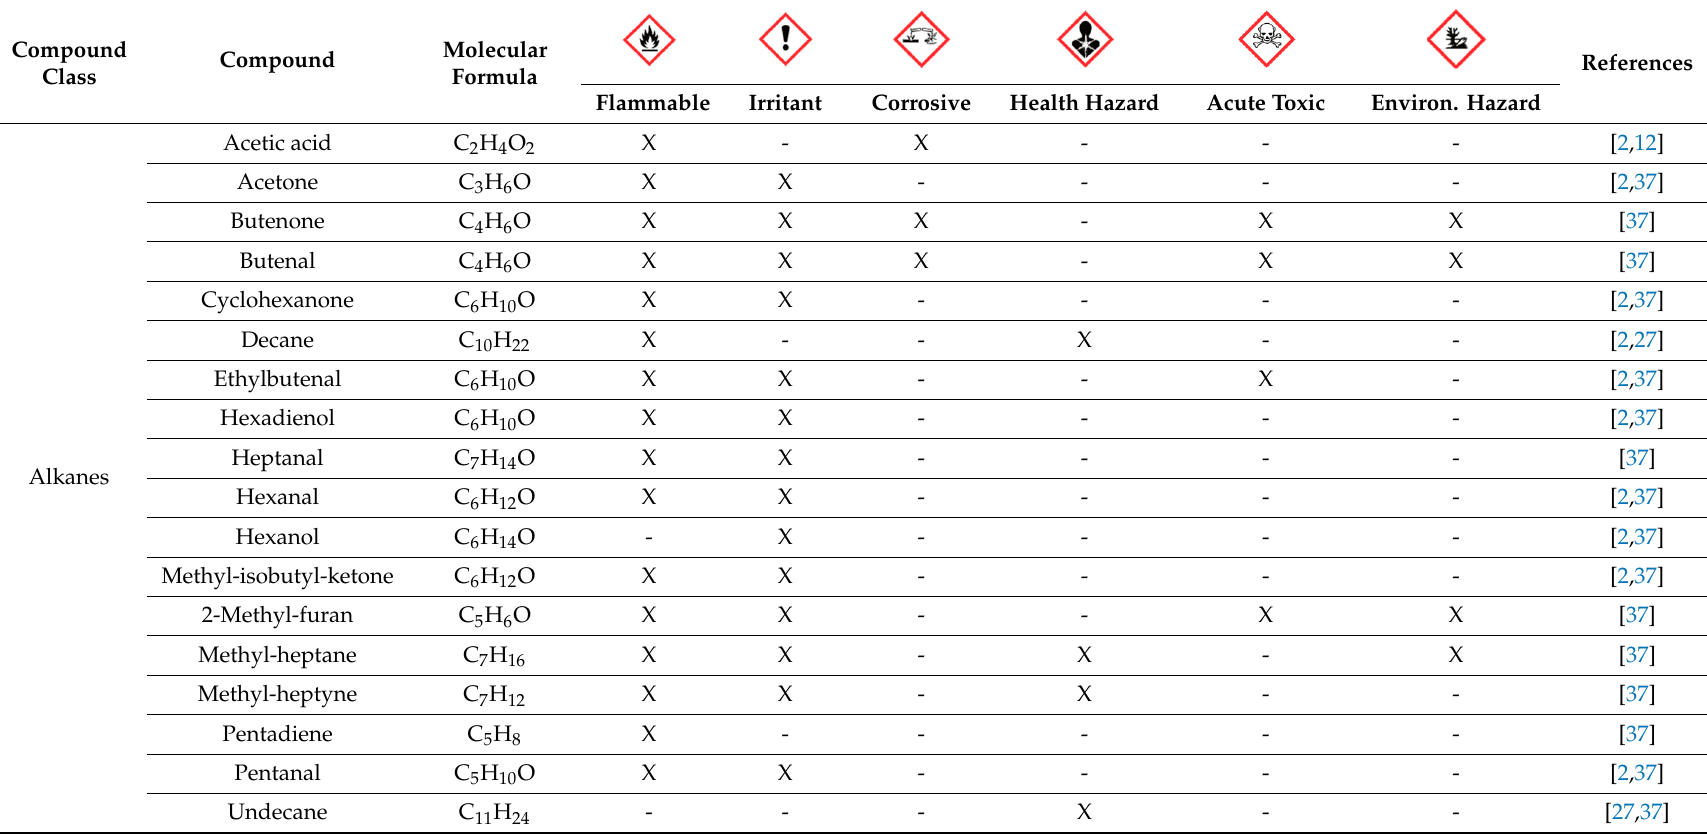
Table 2. List of VOCs identified by proton-transfer reaction time-of-flight mass spectrometer (PTR-TOF-MS) in bitumen samples. The VOCs are classified for their hazardous potential according to the Globally Harmonized System of Classification and Labeling of Chemicals (GHS) [36].